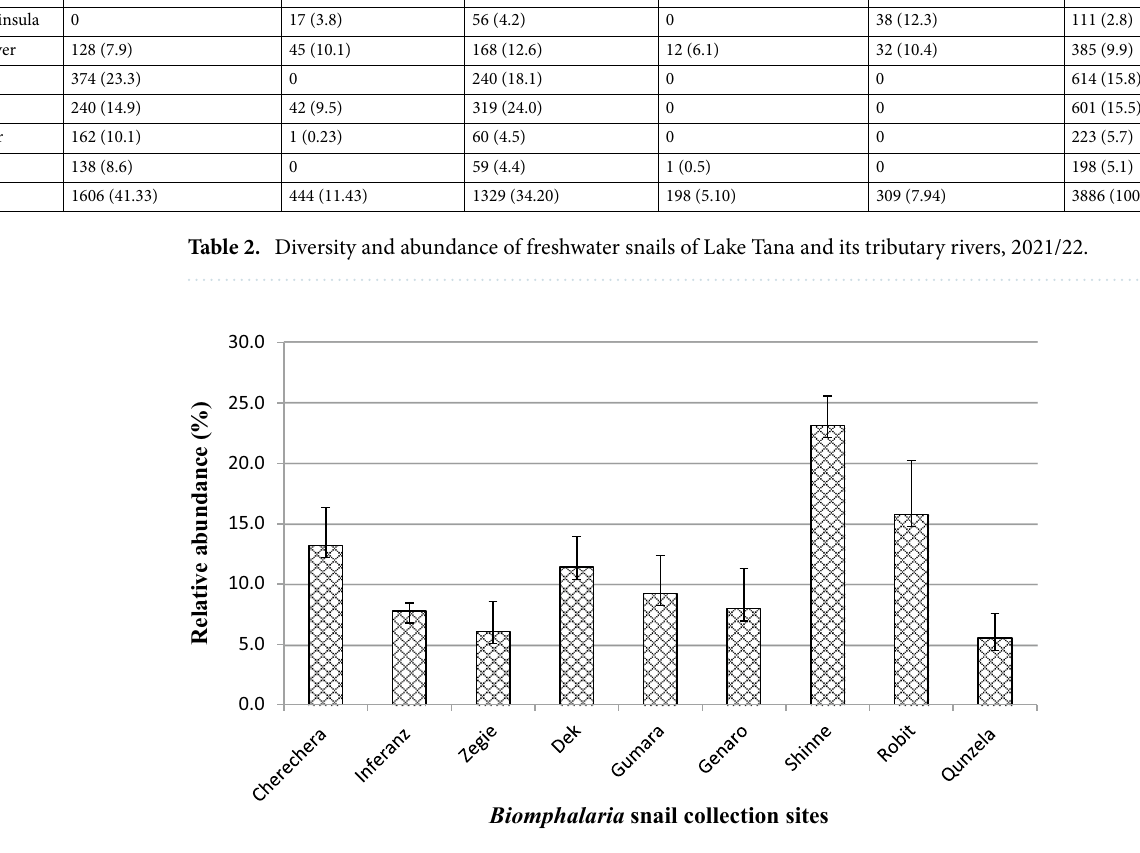
Figure 4. Relative abundance of Biomphalaria snails at different collection